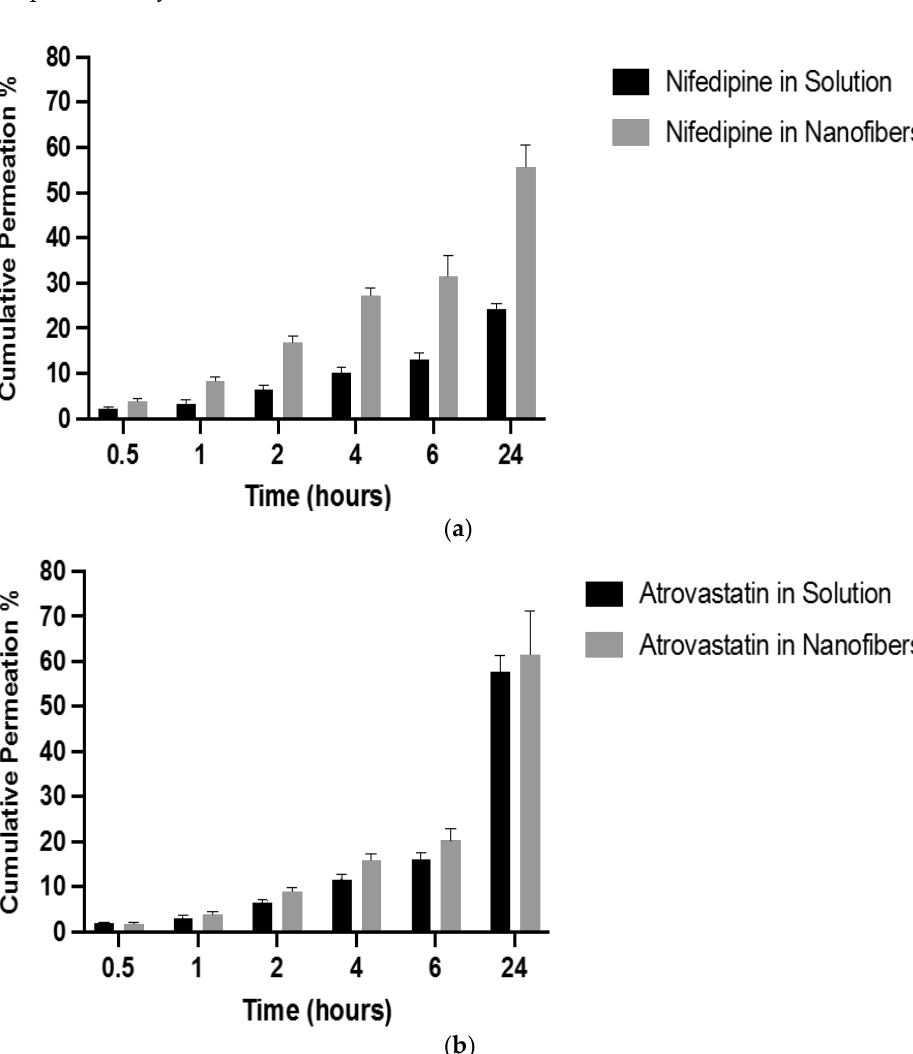
Figure 6. The release profile of the drug-loaded core–shell fibers of nifedipine and atorvastatin cal- cium showed a burst release at 10 min, followed by >80% release after 30 min and a complete drug release after 120 min—results represented as mean ± SD ( n = 3).